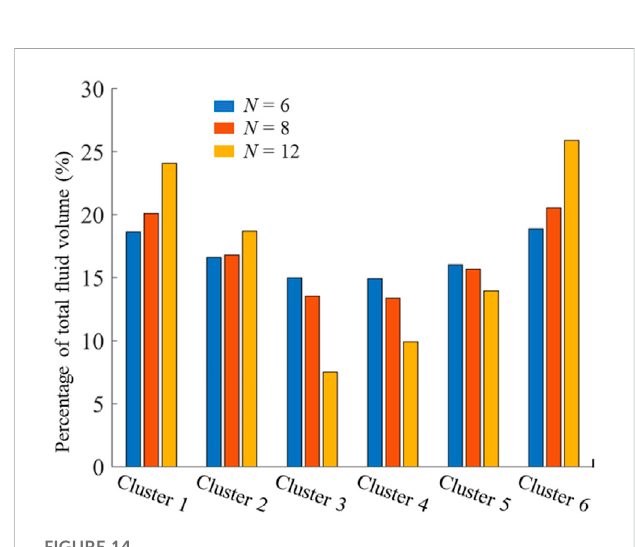
FIGURE 14 The total fl uid volume distribution of each cluster for three cases with different perforation